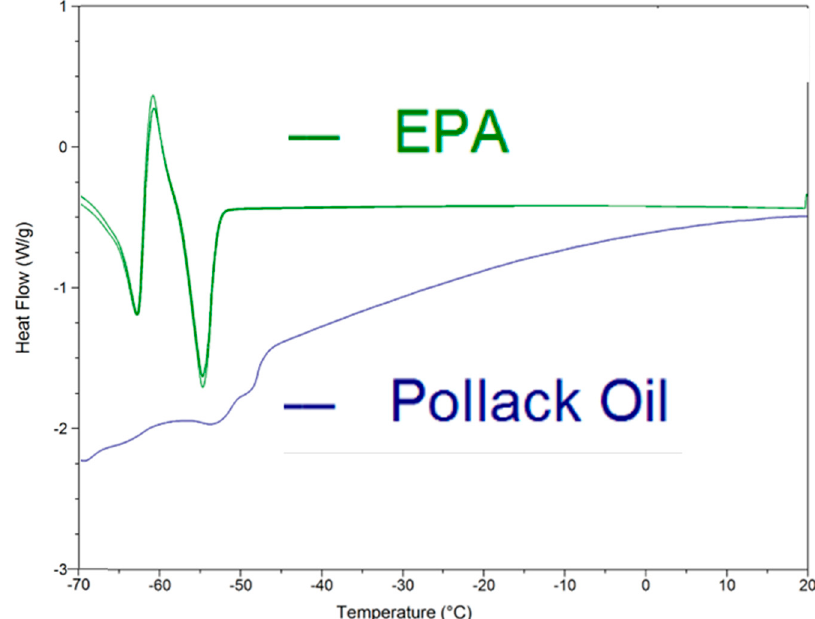
Figure 1. Linear ramp differential scanning calorimetry heat absorption data at 2 °C min − 1 for eicosapentaenoic acid (EPA) and 4 °C min − 1 and pollack oil (PO). From − 70 to − 50 °C EPA shows endothermic-exothermic-endothermic pattern characteristic of a solid state phase transition followed by melting. The reversal curve for EPA shows that the pattern occurs with cooling as well as heating. PO absorbs heat gradually and melts within the − 65 to − 45 °C range.